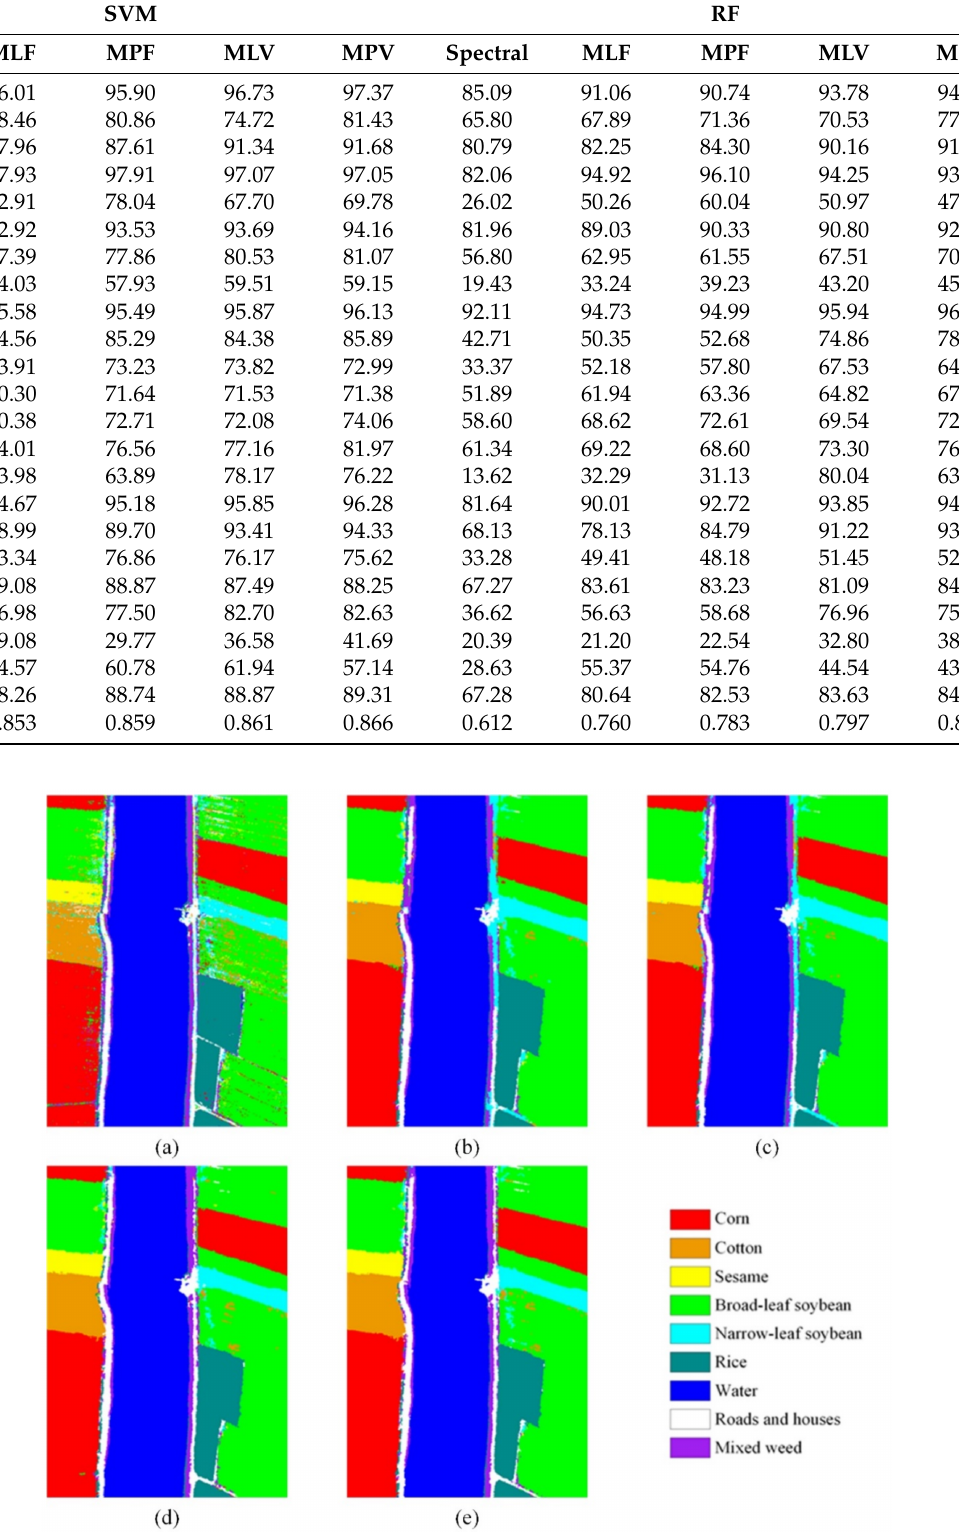
Figure 11. The classification results for the Longkou dataset using SVM: ( a ) Pixel-wise